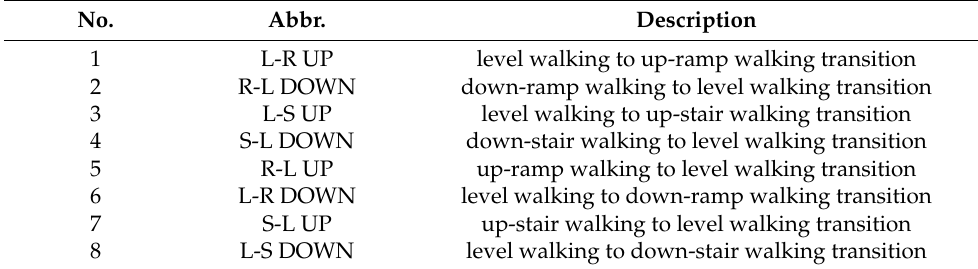
Table 2. Abbreviation and description of gait pattern transitions.